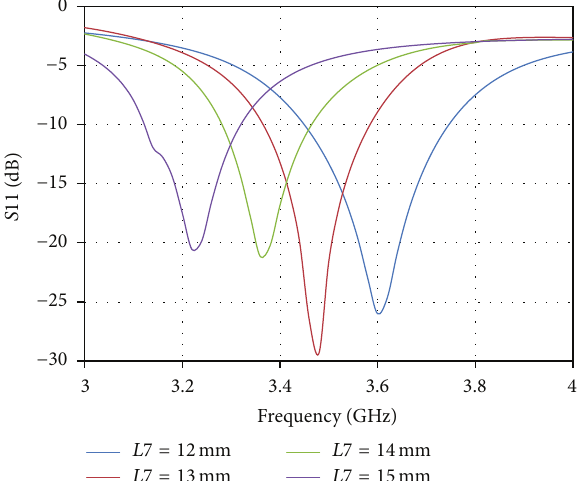
Figure 5: Parametric study on the influence of 𝐻3 .